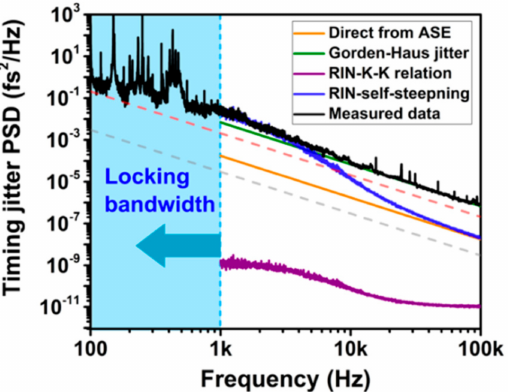
Figure 4. Timing jitter spectrum of a NALM Er-fiber mode-locked laser characterized by DOH technique. Reprint with permission from [45]. Copyright 2020 Optical Society of